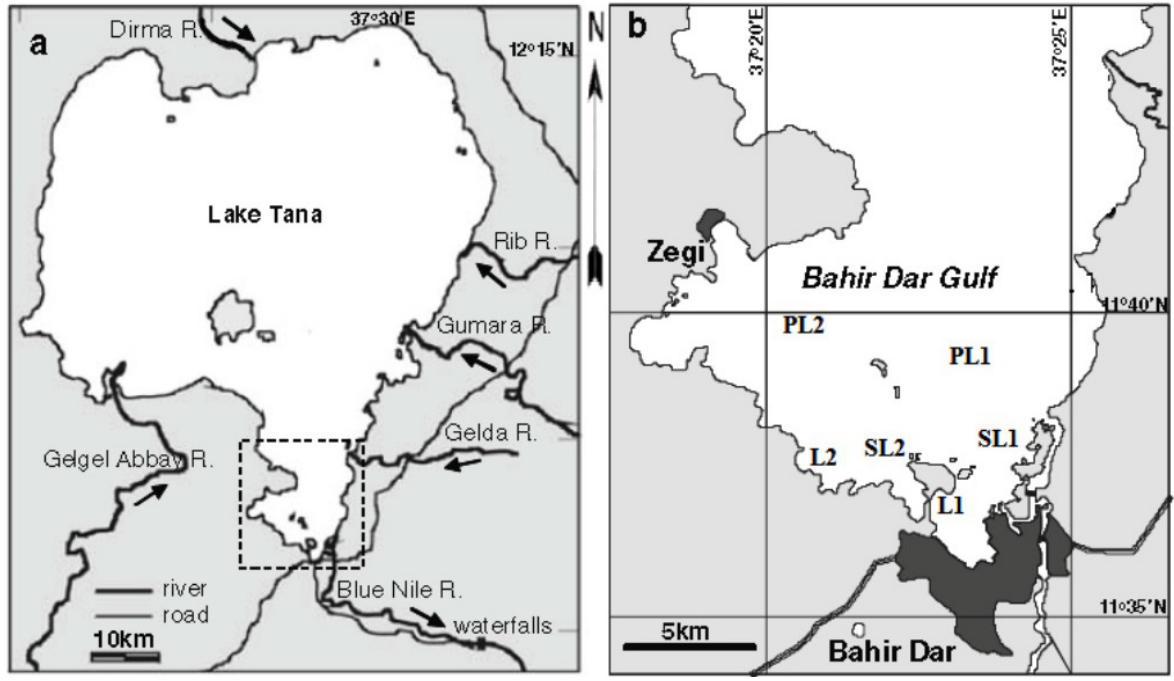
Figure 1. (a) Map of Lake Tana and (b) Sampling stations in the Southern Gulf of Lake Tana with three macro-habitats Littoral (L1: Gerima and L2: Airport), Sub-littoral (SL1: Debremariam and SL2: Bahita) and pelagic (PL1: Kentefami and PL2: Kibran-Zegie) selected for sampling (Modified after Eshete Dejen et al.